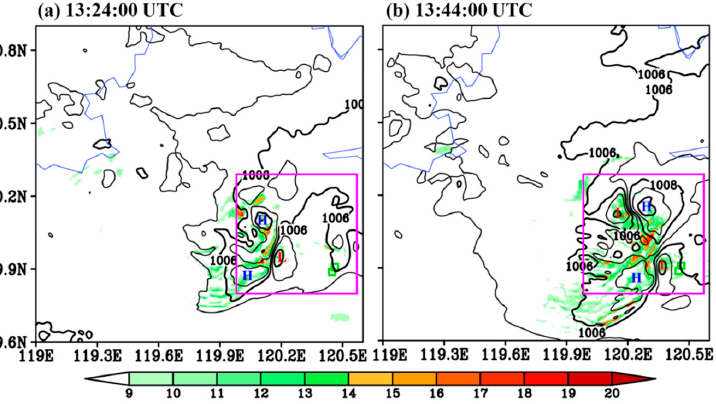
Figure 10. Panels ( a , b ) show the horizontal wind speed (shading; m s − 1 ) and sea level pressure (black contour; hPa) at typical stages, where the purple boxes mark the key region, and the small green boxes mark the locations at which the tower toppling appeared. H = high pressure center; L = low pressure center.